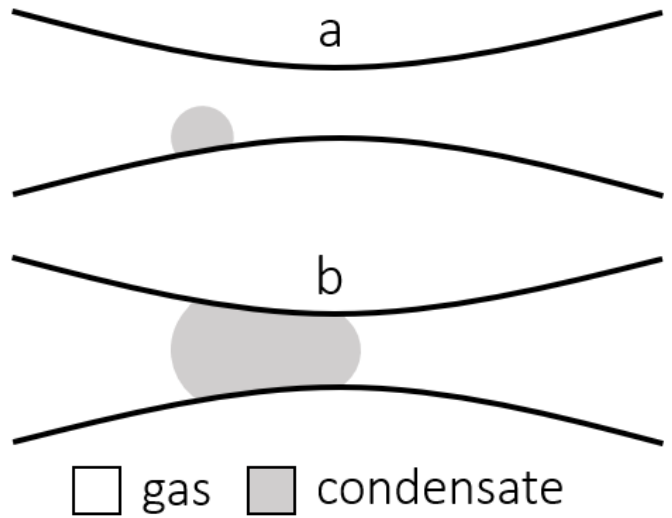
Figure 3. Stages of condensation and flow in a gas-wet capillary. ( a ) Droplet of liquid at initial state of condensation. ( b ) Slug of liquid formed with droplet